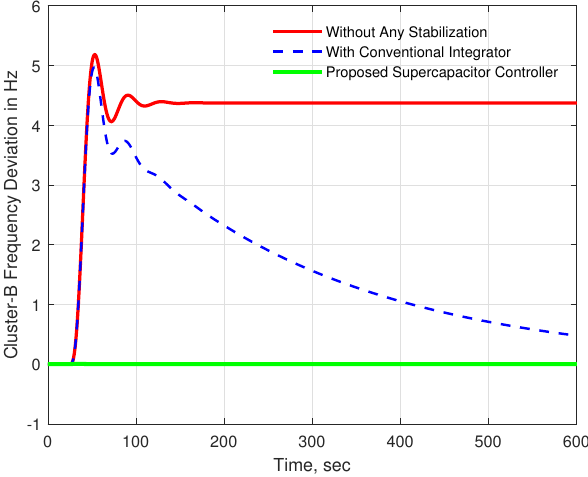
Figure 9. Frequency response for cluster B with 0.15 p.u. disturbance in cluster A. An overall comparison for the disturbances applied in Cluster A is depicted in Figure